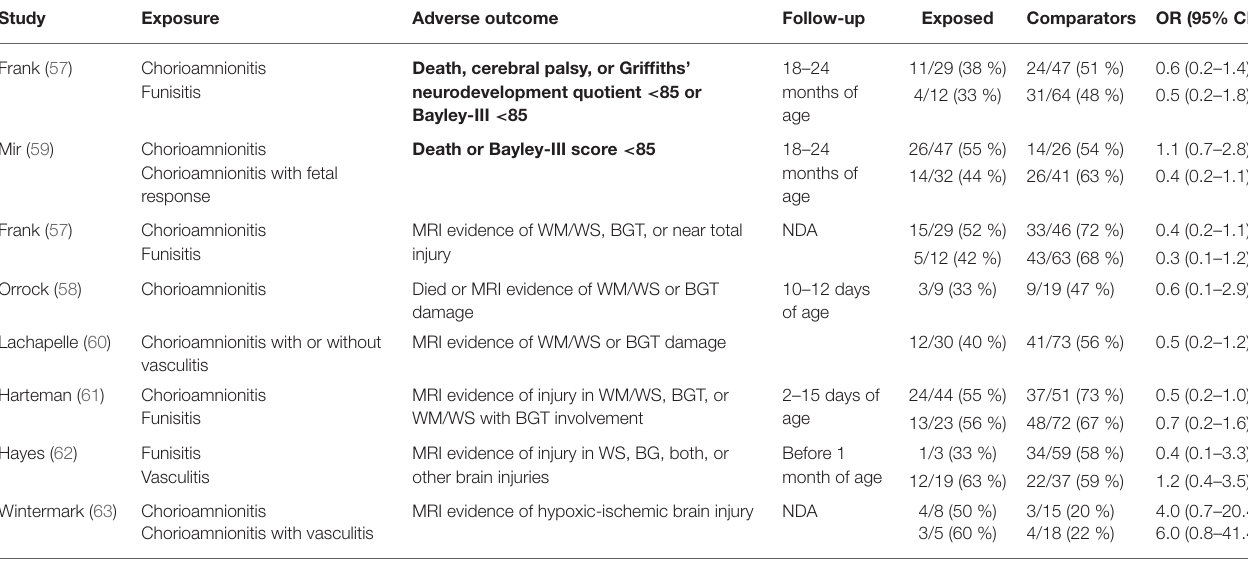
TABLE 3 | Odds ratios (OR) with 95% confidence intervals (CI) of unfavorable neurological outcome between newborns with encephalopathy with and without maternal infection. Study Exposure